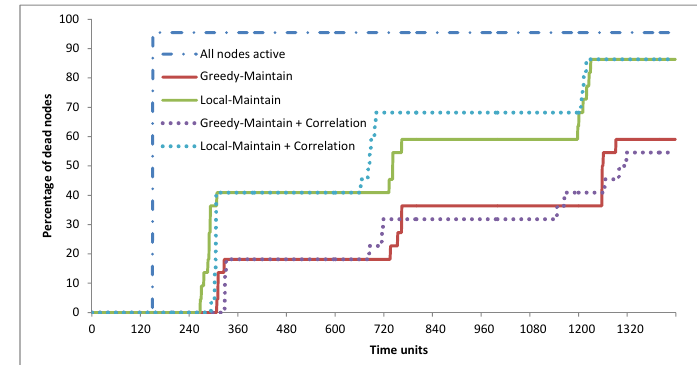
Figure 10. TMON’s percentage of active nodes over time.